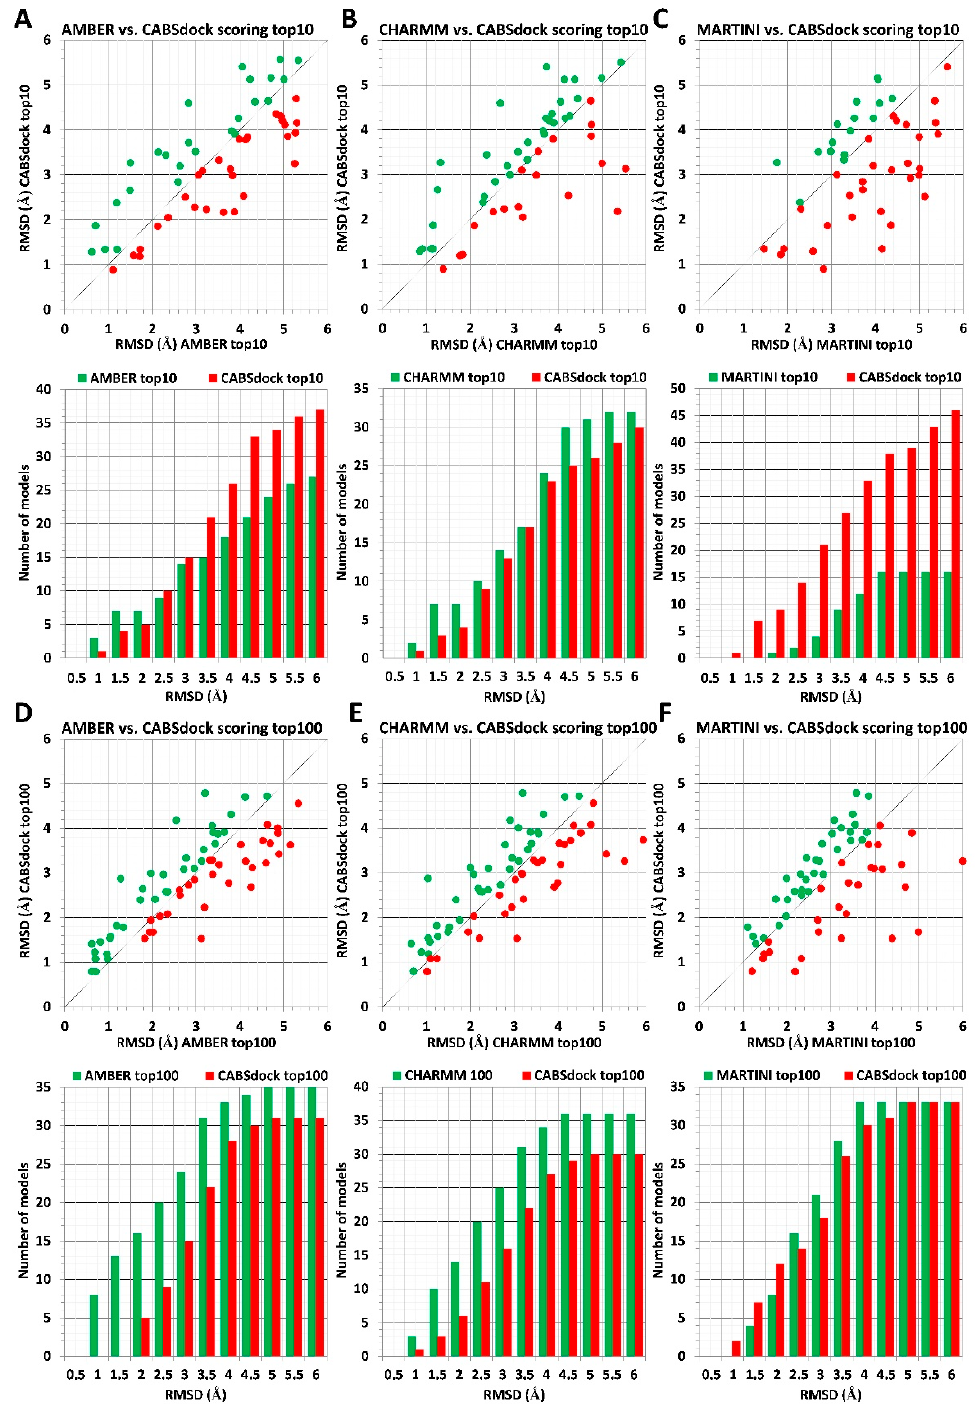
Figure 1. Comparison of MD-based versus CABS-dock scoring. The scoring data for 66 different protein–peptide complexes is shown. MD-based scoring was performed using three different force fields: AMBER, CHARMM, and MARTINI. Panels ( A – C ) show results obtained for sets of top 10 models, and panels ( D – F ) show results for sets of top 100 models. The plot at the top of each panel ( A – F ) shows RMSD values for best rank models according to the MD-based scoring method (color green) vs. RMSD values obtained for CABS-dock models (color red). At the bottom of each panel, the bar plot shows the number of models with the lower RMSD values identified using either the MD-based scoring method (color green) or using the CABS-dock scoring scheme (color red) for 0.5 Å intervals. Plots made based on data from Table S1.